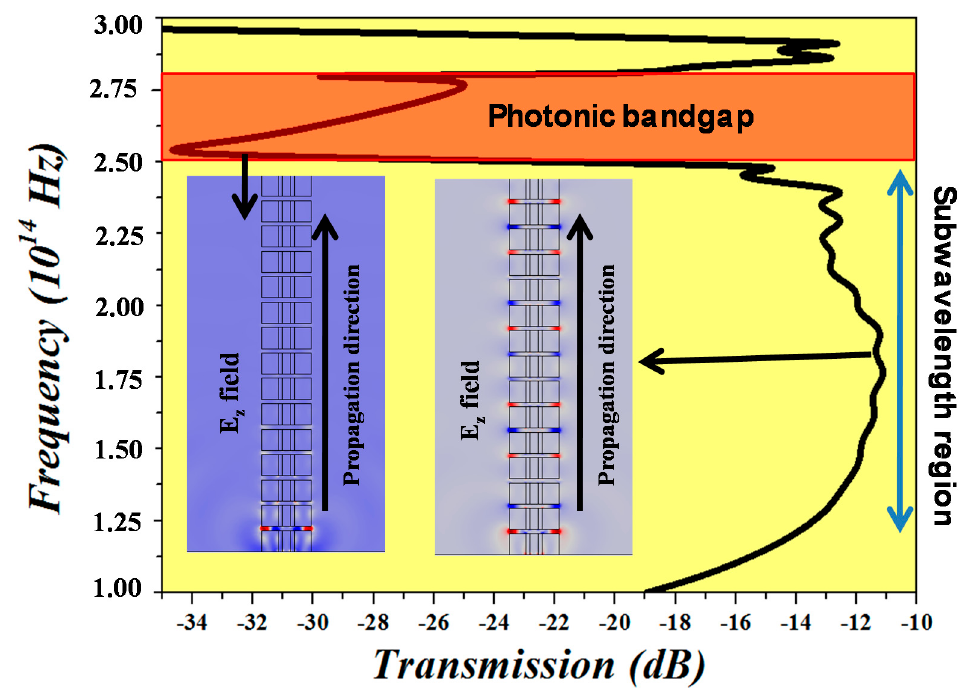
Figure 2. The transmission spectrum of GDSWG which is divided into two regions—photonic bandgap and subwavelength region. Inset of the figure shows the E z plot of a WG in both the regions.